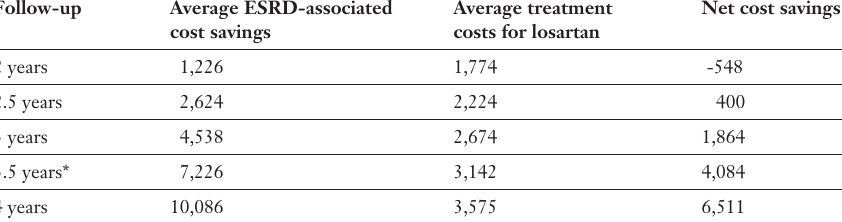
Net cost savings per patient